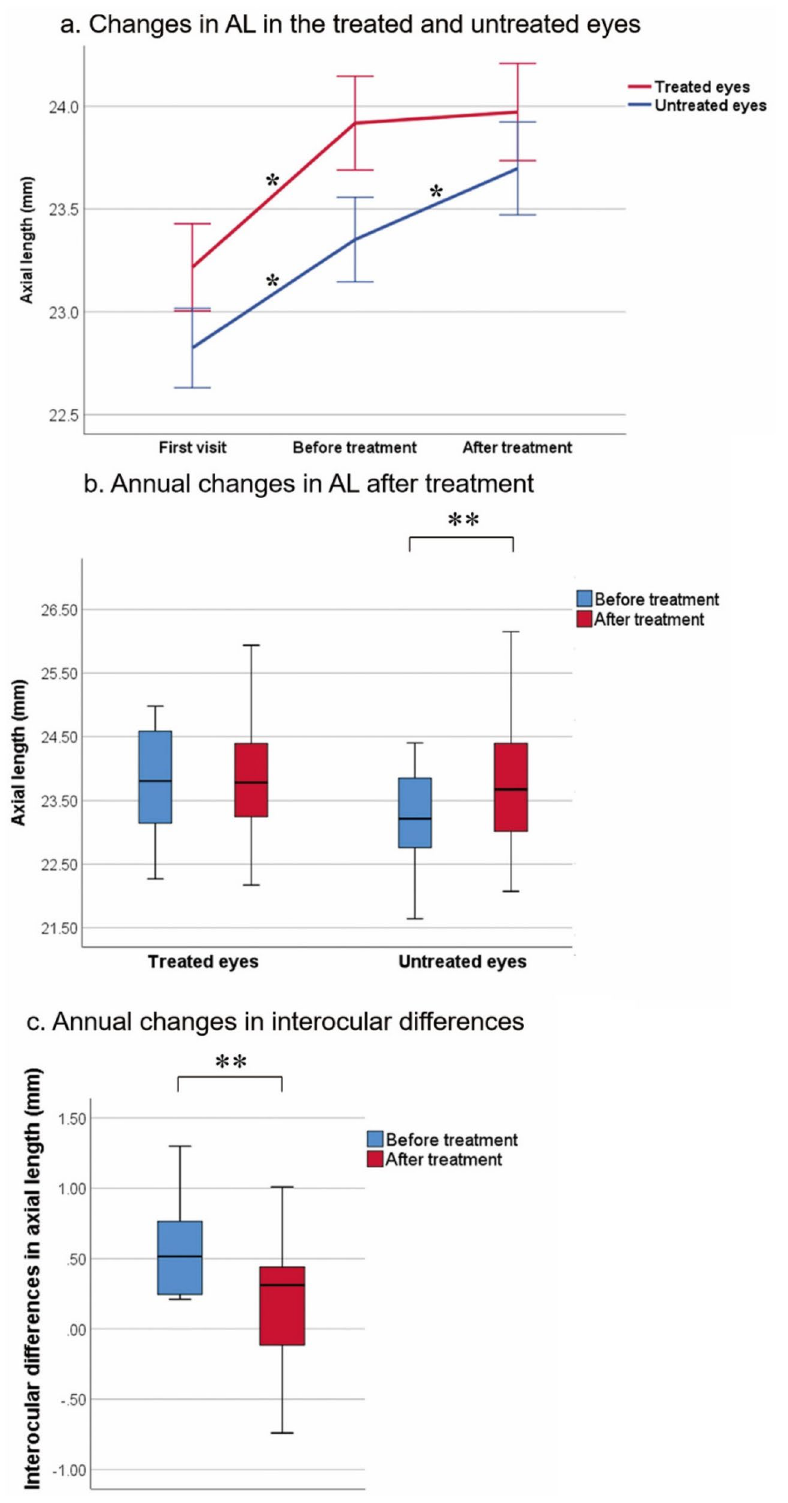
Figure 1. Changes in AL in the treated and untreated eyes during the observation ( n = 32) and treatment ( n = 40) periods and changes in interocular differences after treatment. ( a ) Changes in AL in the treated and untreated eyes. In the treated eyes, AL changed significantly during the observation period ( p < 0.001), but not during the treatment period ( p = 0.389). In the untreated eyes, AL changed significantly during both the observation and treatment periods (both p < 0.001). ( b ) Annual changes in AL were not significant in the treated eyes ( p = 0.596), but were significant in the untreated eyes ( p < 0.001). ( c ) Annual changes in interocular differences decreased significantly ( p < 0.001). * p < 0.001, generalized estimating equation; ** p < 0.001, paired-sample t test. Error bars in panel ( a ) indicate one standard error at each time point and for each group; box plots in panels ( b ) and ( c ) indicate the minimum, first quartile, median, third quartile, and maximum